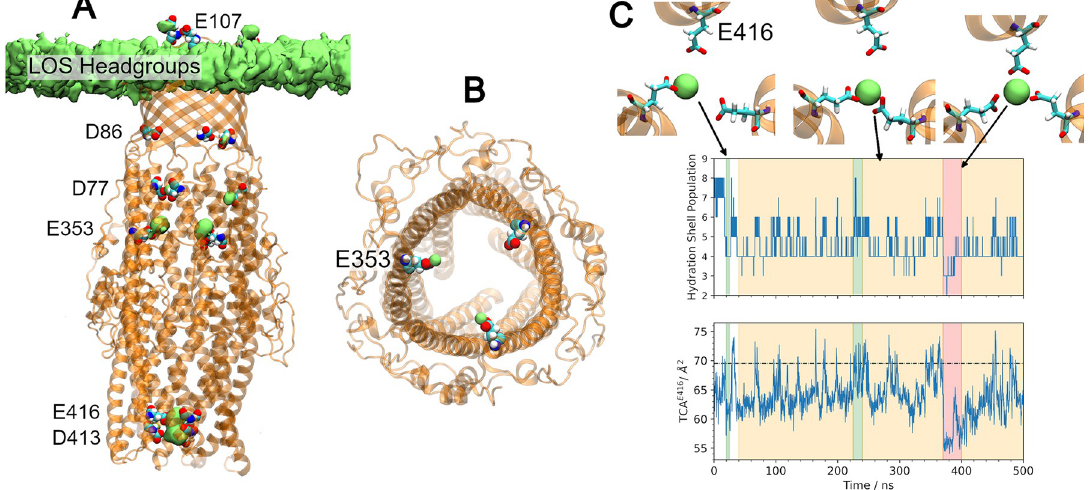
Fig 7. Acidic residues within the channel coordinate calcium ions. (A) Calcium ion density (green surface) located close to acidic residues (VDW, labelled) within the CmeC channel. Considerable calcium ion density was found near residues D413, E416, E353, D77, D86, and E107. (B) Acidic residues above the coiled-coil region coordinate calcium ions in a 1:1 stoichiometry. Here, two calcium ions (green spheres) are bound to two of the three E353 residues. (C) The calcium ions bound to E416 see drastic changes to their hydration shell as 1 (green), 2 (yellow) or all 3 (red) acidic residues coordinate a single cation. Coordination is coupled with the triangular cross- sectional area: as more E416 residues coordinate, the triangular cross-sectional area defined by the E416 alpha carbons decreases. TCA defined in the x-ray crystal structure shown as a dashed black